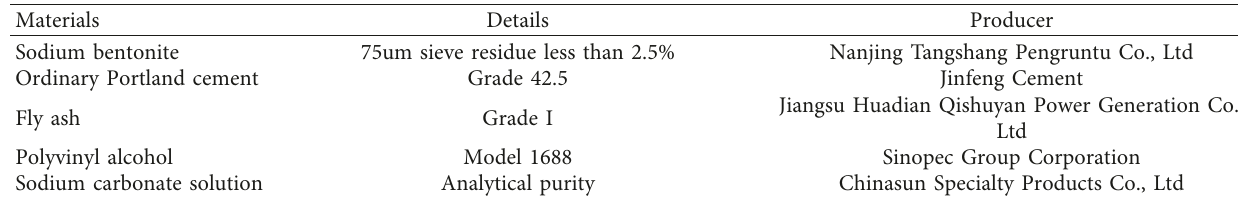
Table 4: Details of materials.